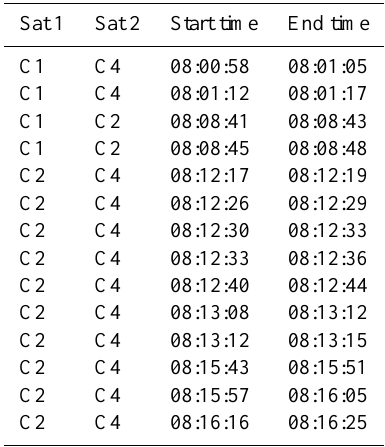
Table 1. Cluster satellite pairs, starting and ending times for each wave packet. Often segments of the wave packets were used in the analysis, rather than whole wave packets. This was done where noise or other waves contaminated sections of the wave packet time series. In practice, only a few oscillations are necessary to determine vector direction from minimum variance analysis. Sat 1 Sat